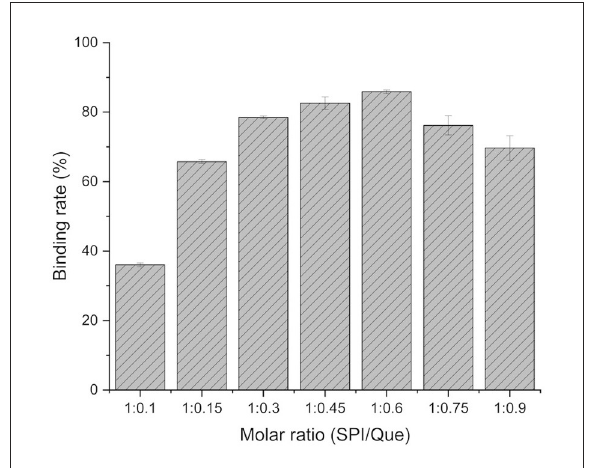
FIGURE1 The binding rate (%) of SPI-quercetin (Que) at different ratio.